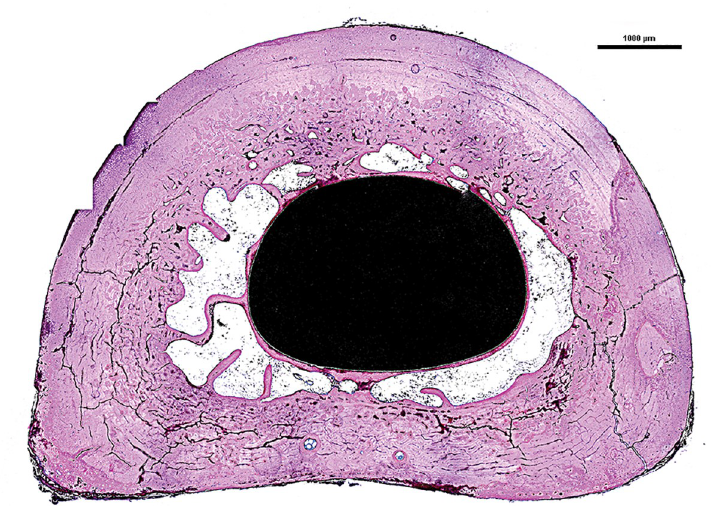
Fig 7. Photomicrograph of representative bone-endoprosthesis stem interface stained with Sanderson rapid bone stain: Black = endoprosthesis, pink = bone and blue = fibrous tissue. Scale bar = 1000 μ m.